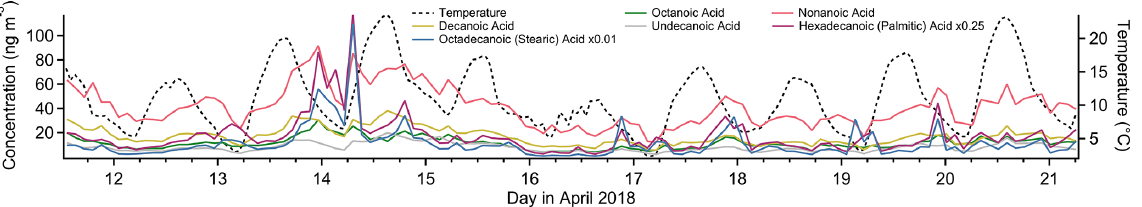
emissions of both hydrocarbons and NO x from automobile tailpipes are low overnight but increase in the early morning hours as morning commutes begin with cold engine